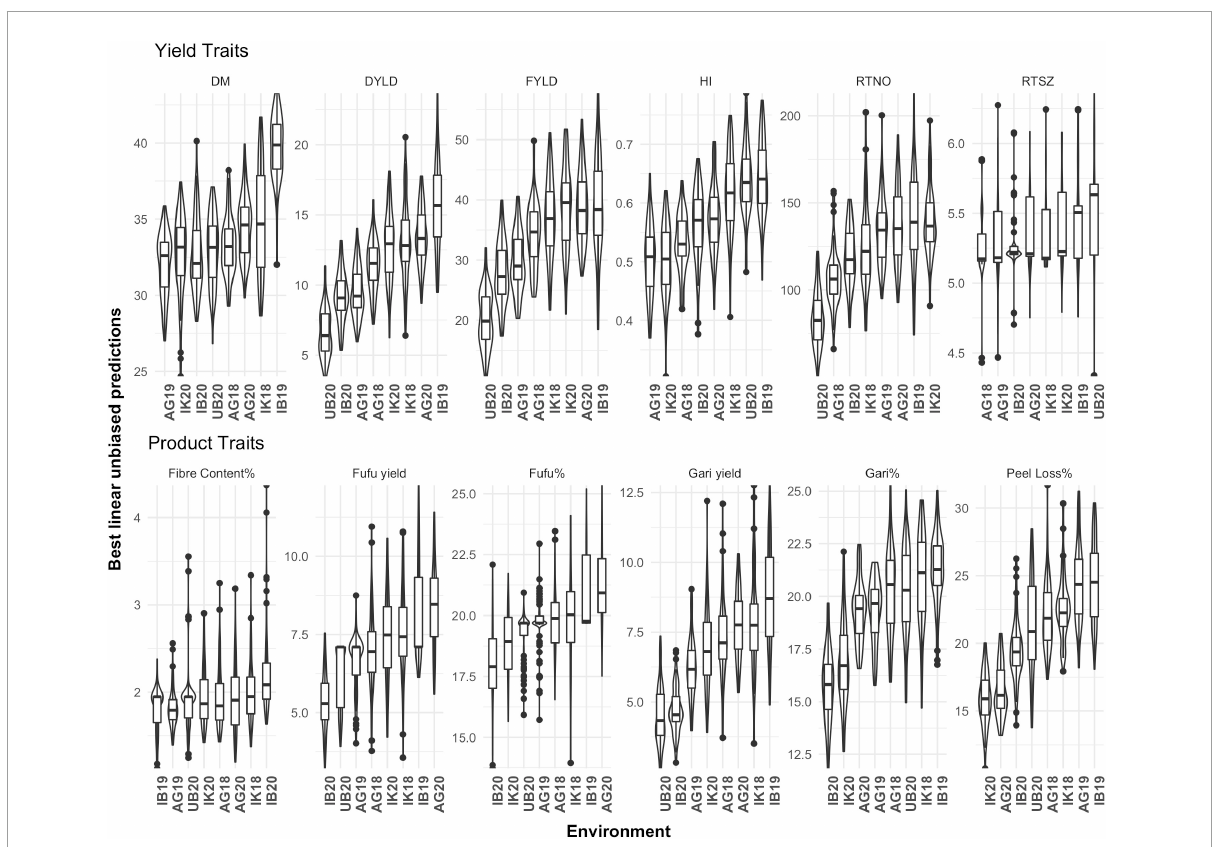
FIGURE1 Phenotypic variation of 12 yield and product traits of cassava across eight environments. IB19, Ibadan 2019; IK18, Ikenne 2018; AG19, AgoOwo 2019; UB20, Ubiaja 2019; IK20, Ikenne 2020; Env, Environment; DM, Dry matter; DYLD, Dry root yield; FYLD, Fresh root yield; HI, Harvest rate; RTNO, Root number; RTSZ, Root